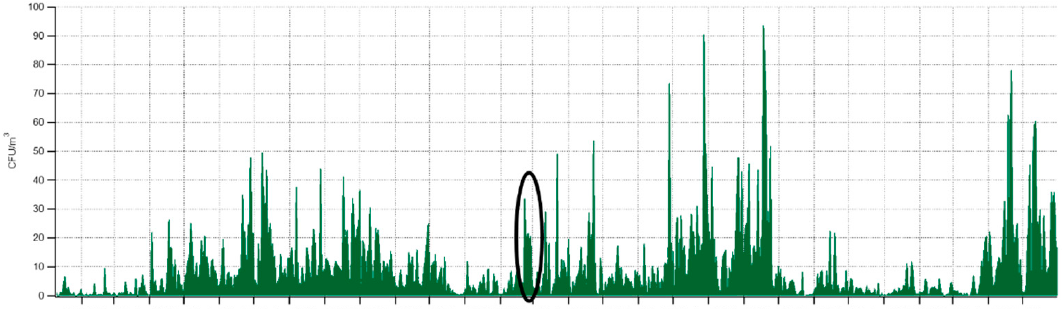
Figure 6. Daily variability of airborne cultivable bacteria at Saclay. The dark circle highlights the pollution episode from 21 February 2019 to 24 February 2019.